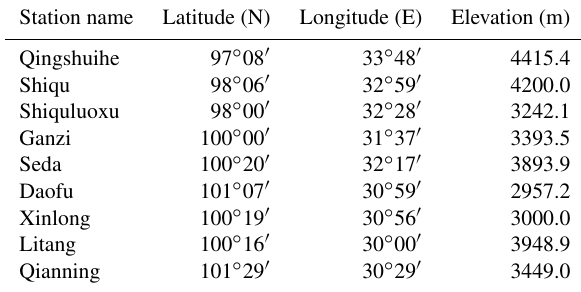
Table 1. Weather stations in the basin.